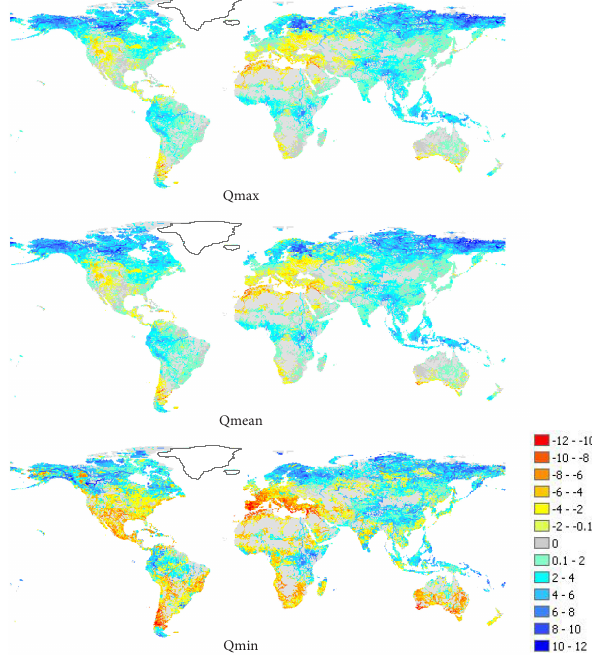
Fig. 7. Maps showing the number of models projecting significant change (for a significance level of 5%) in the same direction as the ensemble mean direction of change (see Sect. 2.4 for more in- formation). From top to bottom the figure shows GCM consisten- cies for maximum, mean and minimum discharge. Negative values correspond to the number of models projecting discharge decrease, positive values correspond to the number of models projecting dis- charge increases, grey areas correspond to areas with no significant